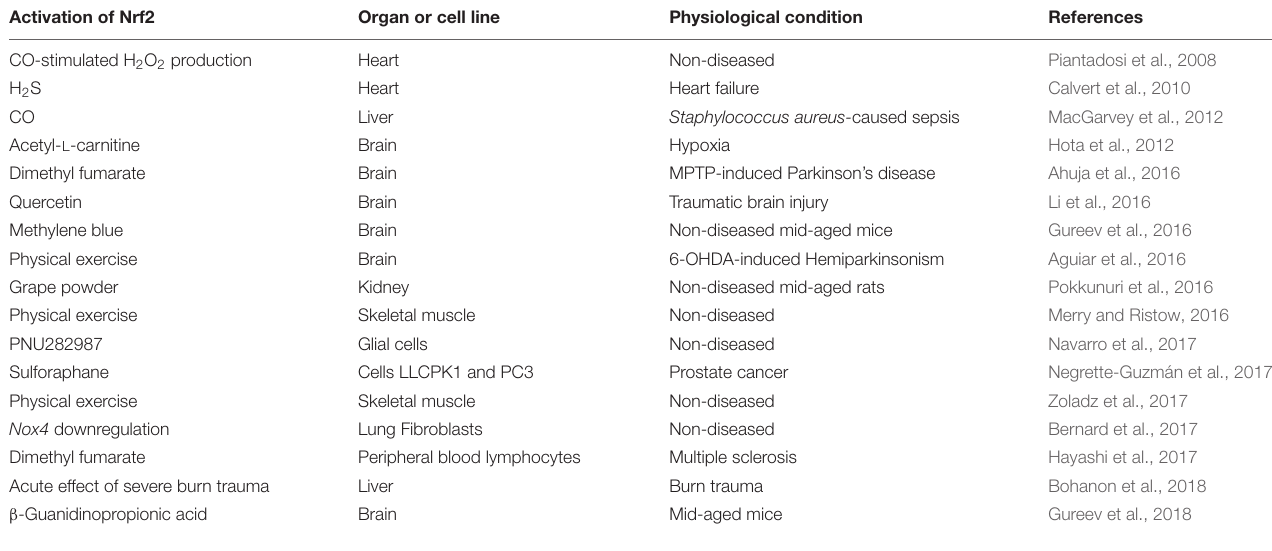
TABLE 1 | Activation of mitochondrial biogenesis via Nrf2/ARE signal